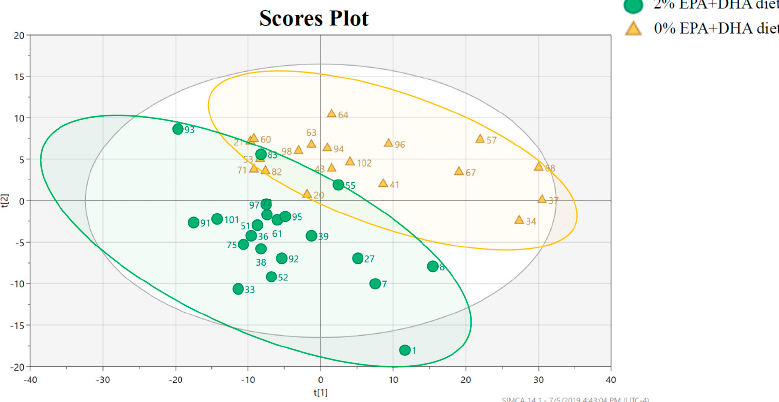
Figure 4. Two dimensional PLS-DA plot with data points representing individual animals supplemented Figure4. TwodimensionalPLS-DAplotwithdatapointsrepresentingindividualanimalssupplemented with 2% EPA+DHA diet (green dot, n = 21) or 0% EPA+DHA diet (orange triangles, n = 19) performed on with 2% EPA + DHA diet (green dot, n = 21) or 0% EPA + DHA diet (orange triangles, n = 19) performed on 500 analytes. R 2 = 63%, Q 2 = 0.553, CV-ANOVA P value = 5.98 × 10 − 7 , and the post-permutation test (200 permutation) Q 2 = −